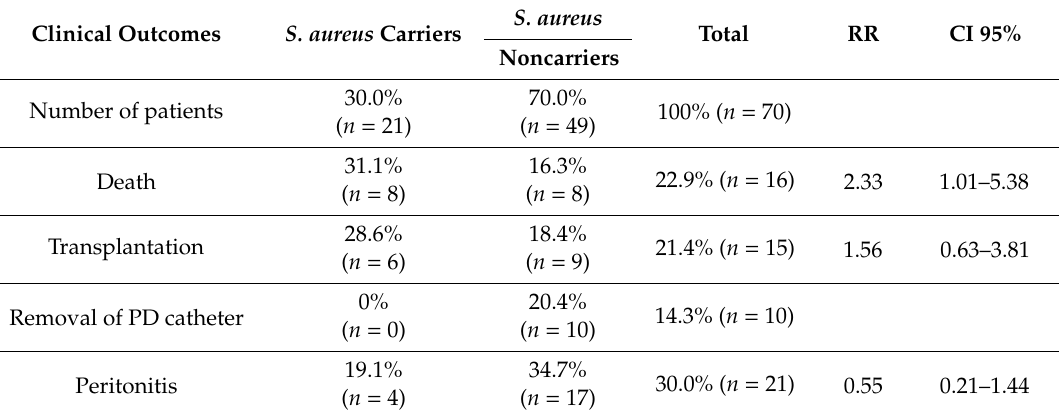
Table 2. Two-year outcome of screened